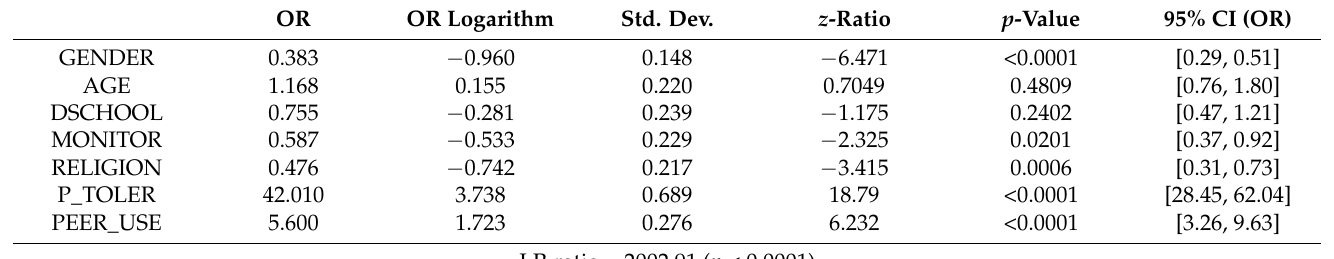
Table 5. Ordered logistic regression